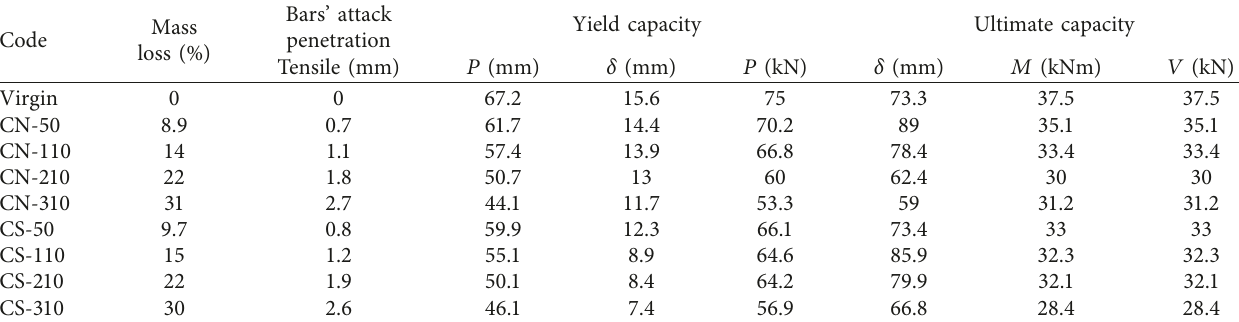
Table 2: Data of specimens tested by El Maaddawy et al.